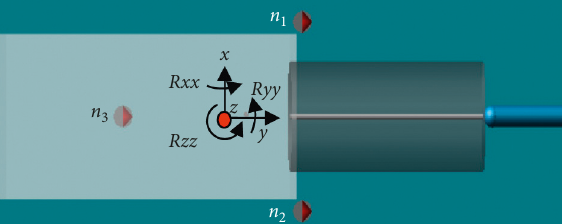
Figure 5: Six-direction decoupling and mounting node position of the